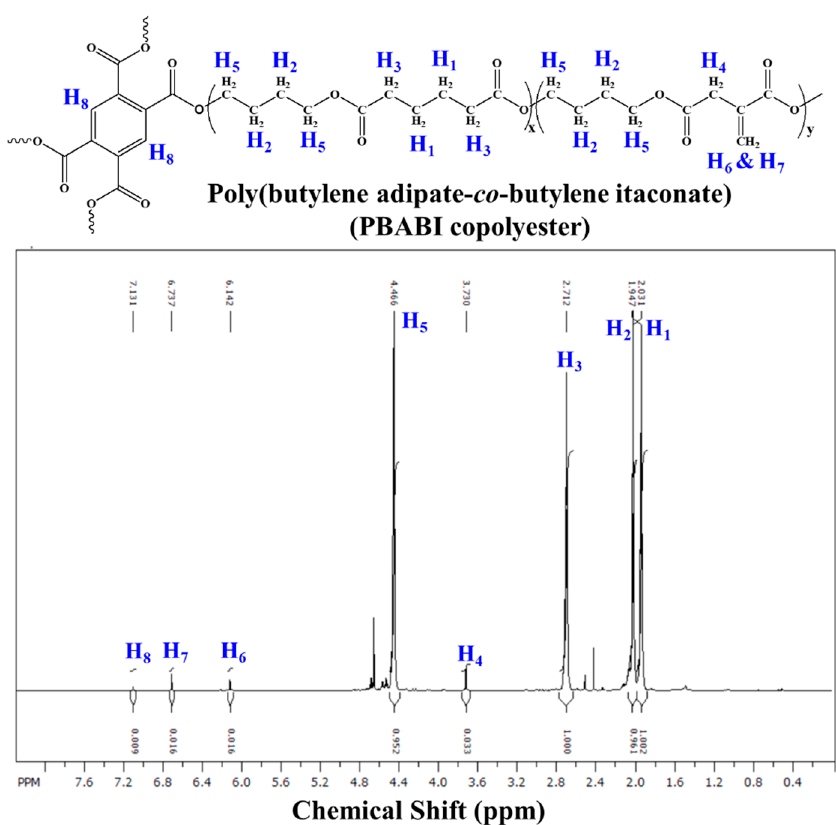
Figure 1. 1 H NMR spectra of PBABI copolyester at a ratio of BA/BI = 90/10.